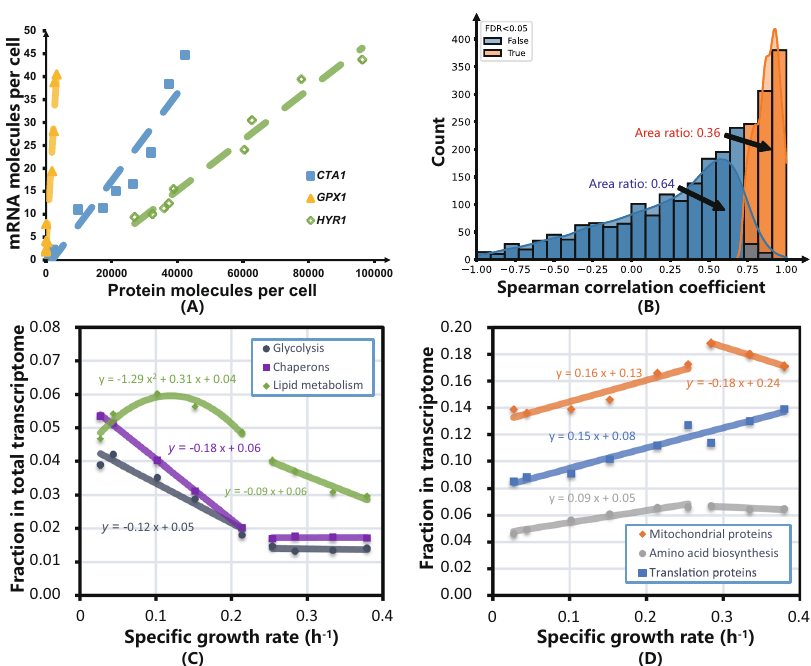
Fig. 2 Correlation analysis of the transcriptome and proteome and allocation of the transcriptome into different functional categories. A Perfect monotone (with Spearman correlation coef fi cient R = 1) correlations between absolute protein and mRNA abundance at the individual gene level across different growth rates, illustrated with the three genes CTA1 , GPX1 , and HYR1 . These three genes are chosen here since they stand out when performing GO term enrichment analysis and commonly fall into three GO function terms. B Distribution of Spearman rank correlation coef fi cients for individual proteins vs. their corresponding mRNA levels across different speci fi c growth rates. Here, FDR < 0.05 was used to distinguish between signi fi cant correlation (in orange) and random correlation (in blue). C Changes in the fraction of mRNAs allocated to translation, mitochondrial, and amino acid biosynthesis across different speci fi c growth rates. D Changes in the fraction of mRNAs allocated to chaperones, glycolysis, and lipid metabolism across different speci fi c growth rates. Source data are provided as a Source Data fi